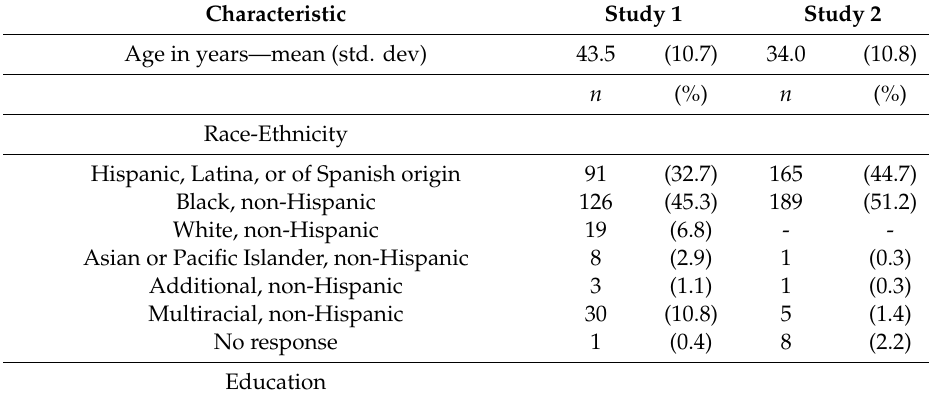
Table 1. Descriptive characteristics of participants in Study 1 ( N = 278) and Study 2 ( N =